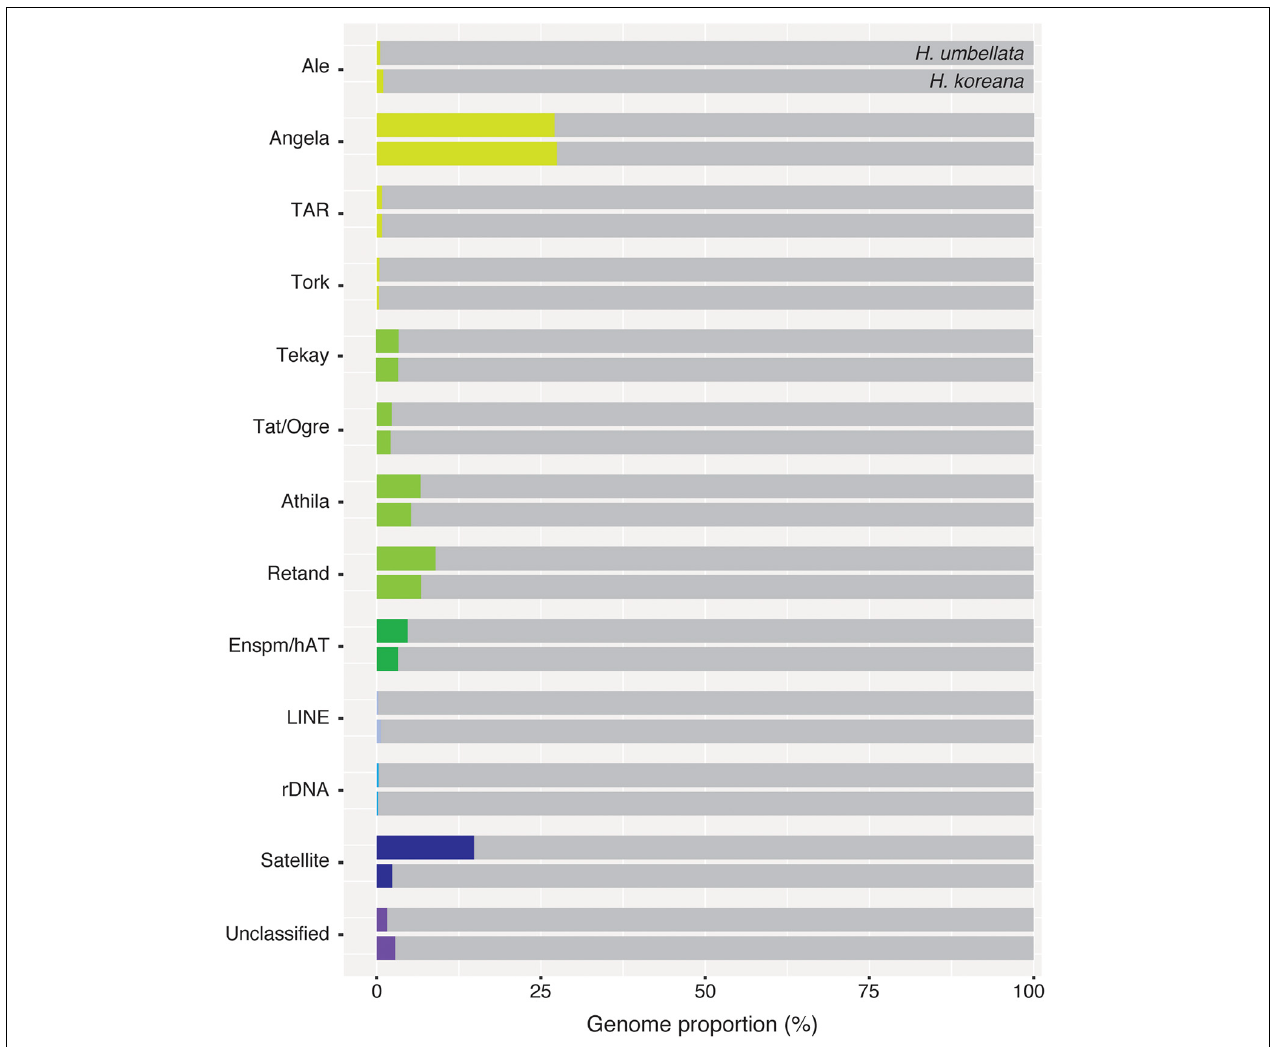
FIGURE 3 | Genomic proportions (in %) of shared repetitive elements between Heloniopsis koreana and H. umbellata